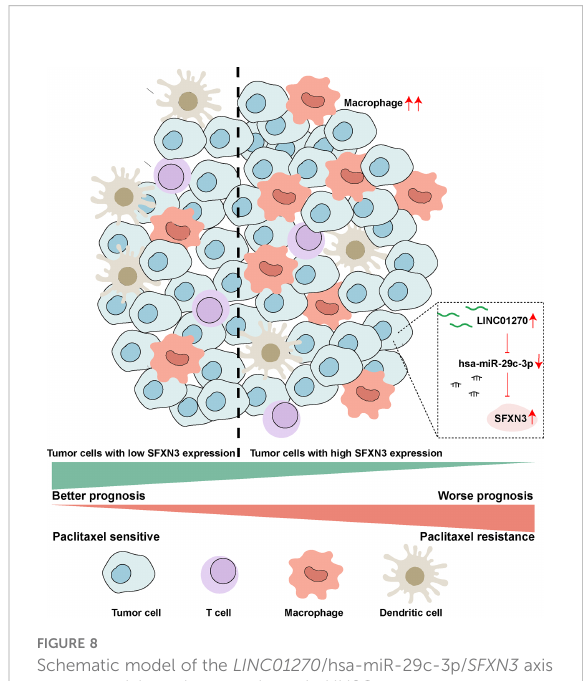
FIGURE 8 Schematic model of the LINC01270 /hsa-miR-29c-3p/ SFXN3 axis as a potential regulatory pathway in